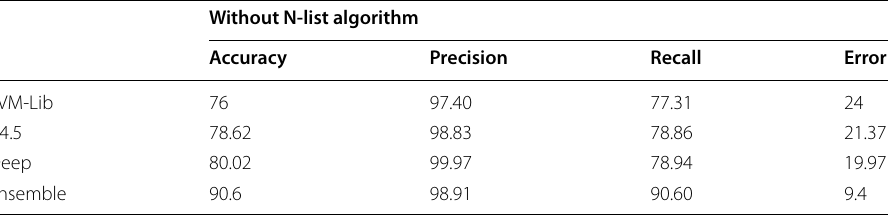
Table 13 Accuracy, precision, recall and error rate of the SVM-Lib, C4.5 and deep neural network algorithm for basket analysis without the N-LIST algorithm